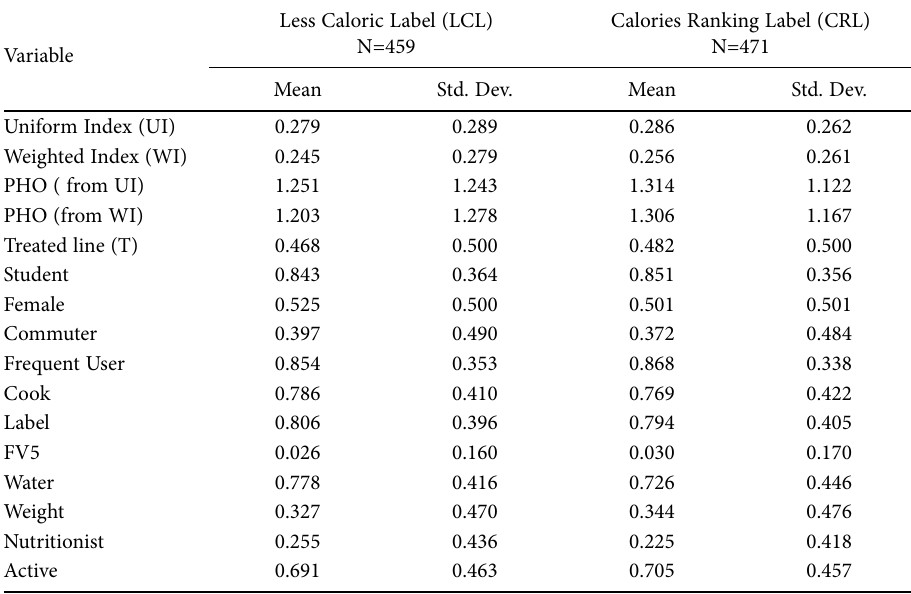
Table 3. Summary